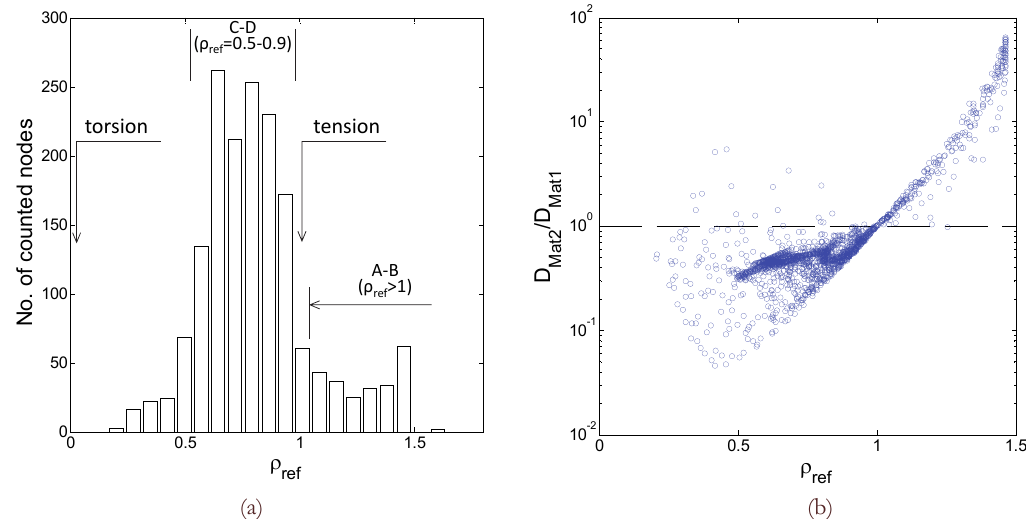
Figure 9: (a) Distribution of ρ ref values in FE nodes; (b) damage ratio D Mat2 / D Mat1 vs. ρ ref values (each point refers to one nodal